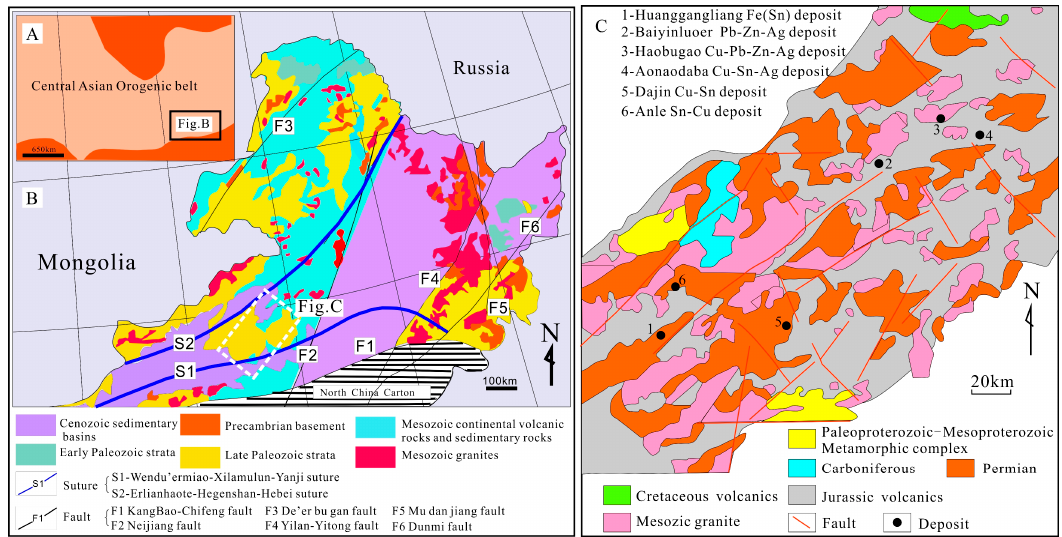
Figure 1. Geological sketch map and distribution of deposits in central Inner Mongolia, adjacent areas ( A , B ) and the southern segment of the Great Hinggan Range ( C ), modified from Reference [3].